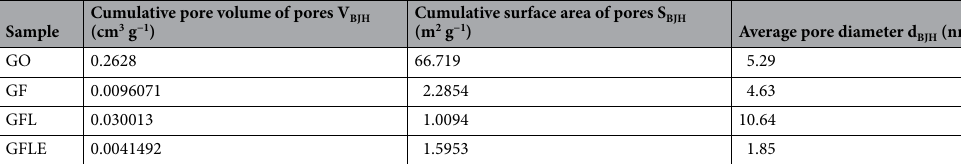
Table 4. BJH experimental results of